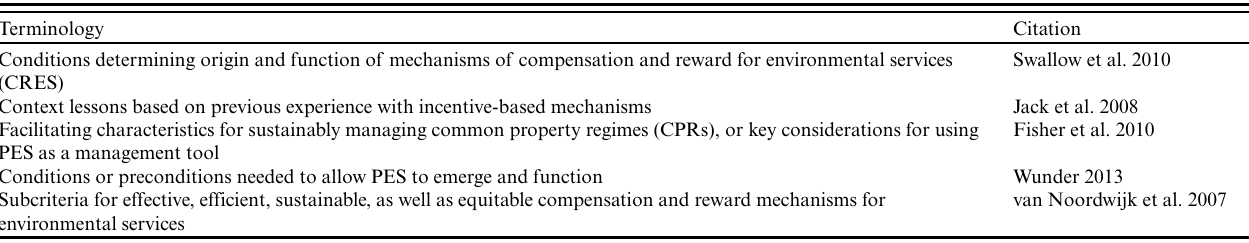
Table 2 . Selected terminology examples for enabling conditions for the development of payment for ecosystem services